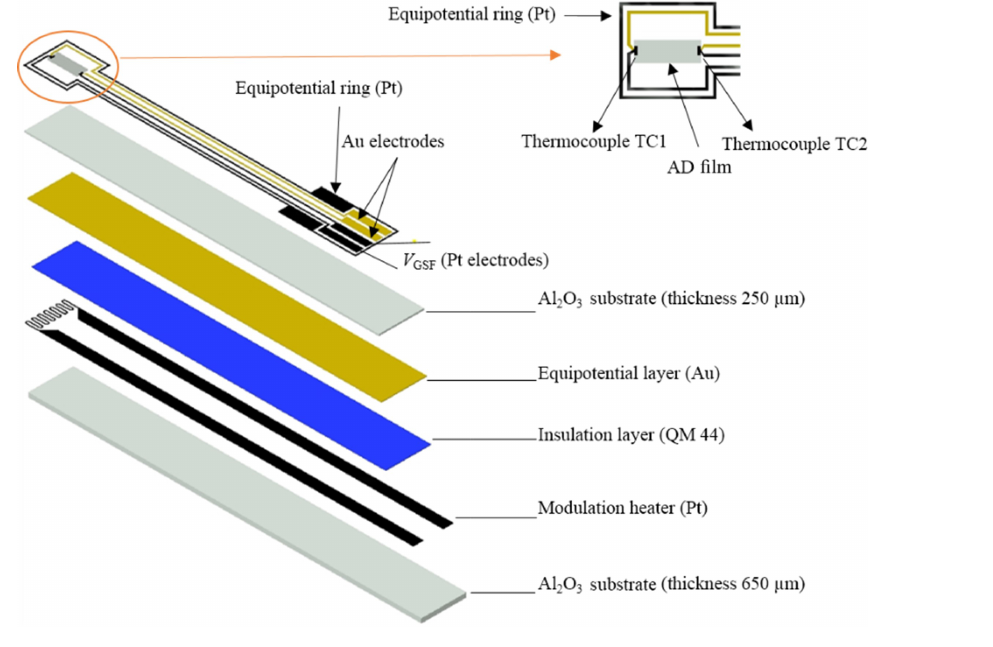
Figure 5. Sketch of the combined thermoelectric–conductometric sensor.